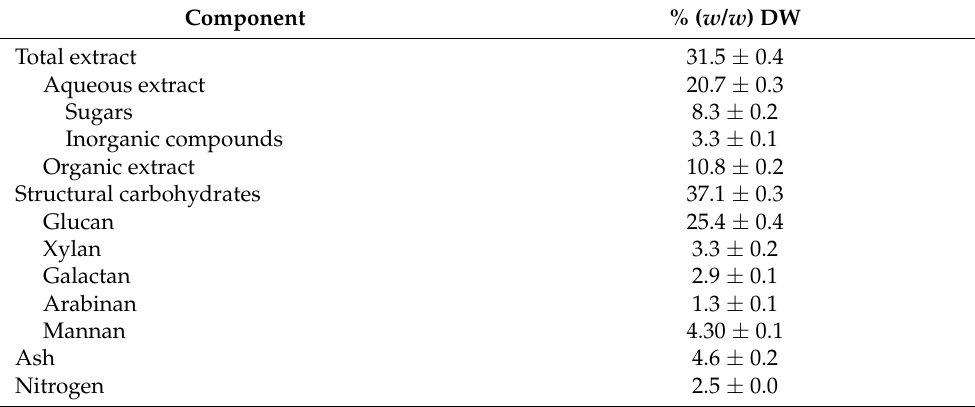
Table 8. Composition of the solid fraction (SF-CT) obtained after crushing and centrifugation of culled tomato residue (CT). Data expressed as percentage ( w/w ) on a DW